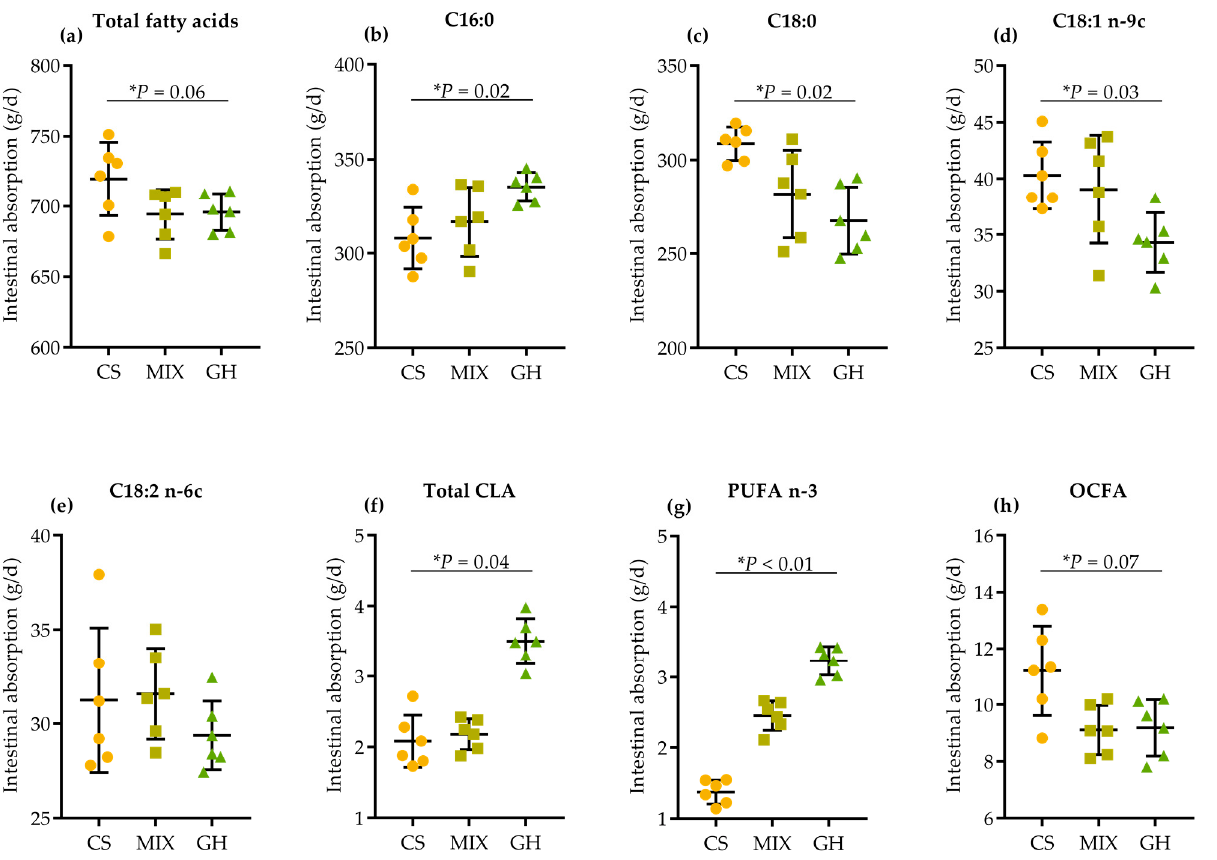
Figure 2. Effects of different dietary forage sources on apparent intestinal absorption of ( a ) total FA, ( b ) C16:0, ( c ) C18:0, ( d ) C18:1 n ‐ 9c, ( e ) C18:2 n ‐ 6c, ( f ) total CLA, ( g ) n ‐ 3 PUFA, and ( h ) OCFA of cows.